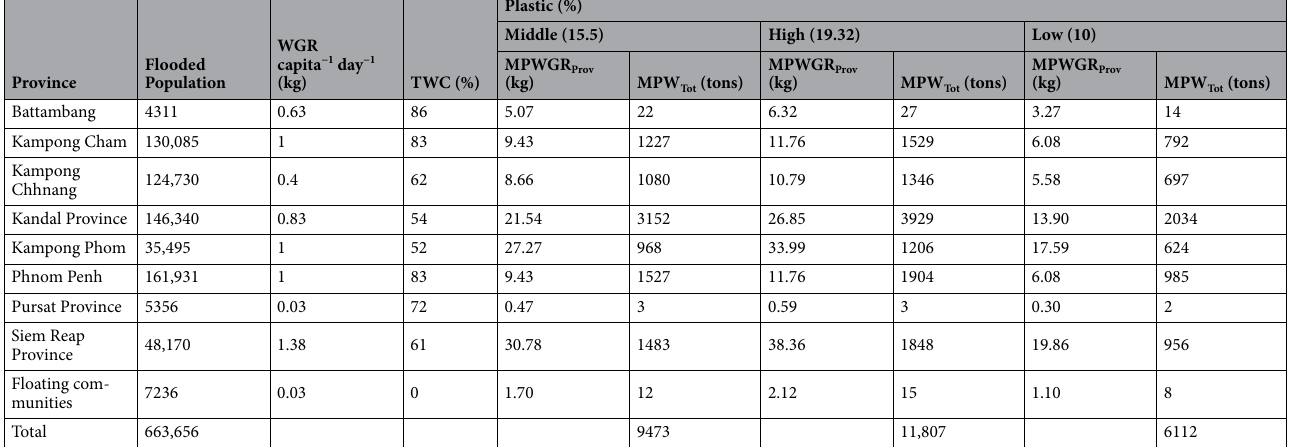
Table 2. Annual mismanaged plastic waste generation rate ( AnnualMPWGR Prov ) per capita and total mismanaged plastic waste AnnualMPW Tot in 2018 within the flood boundary.